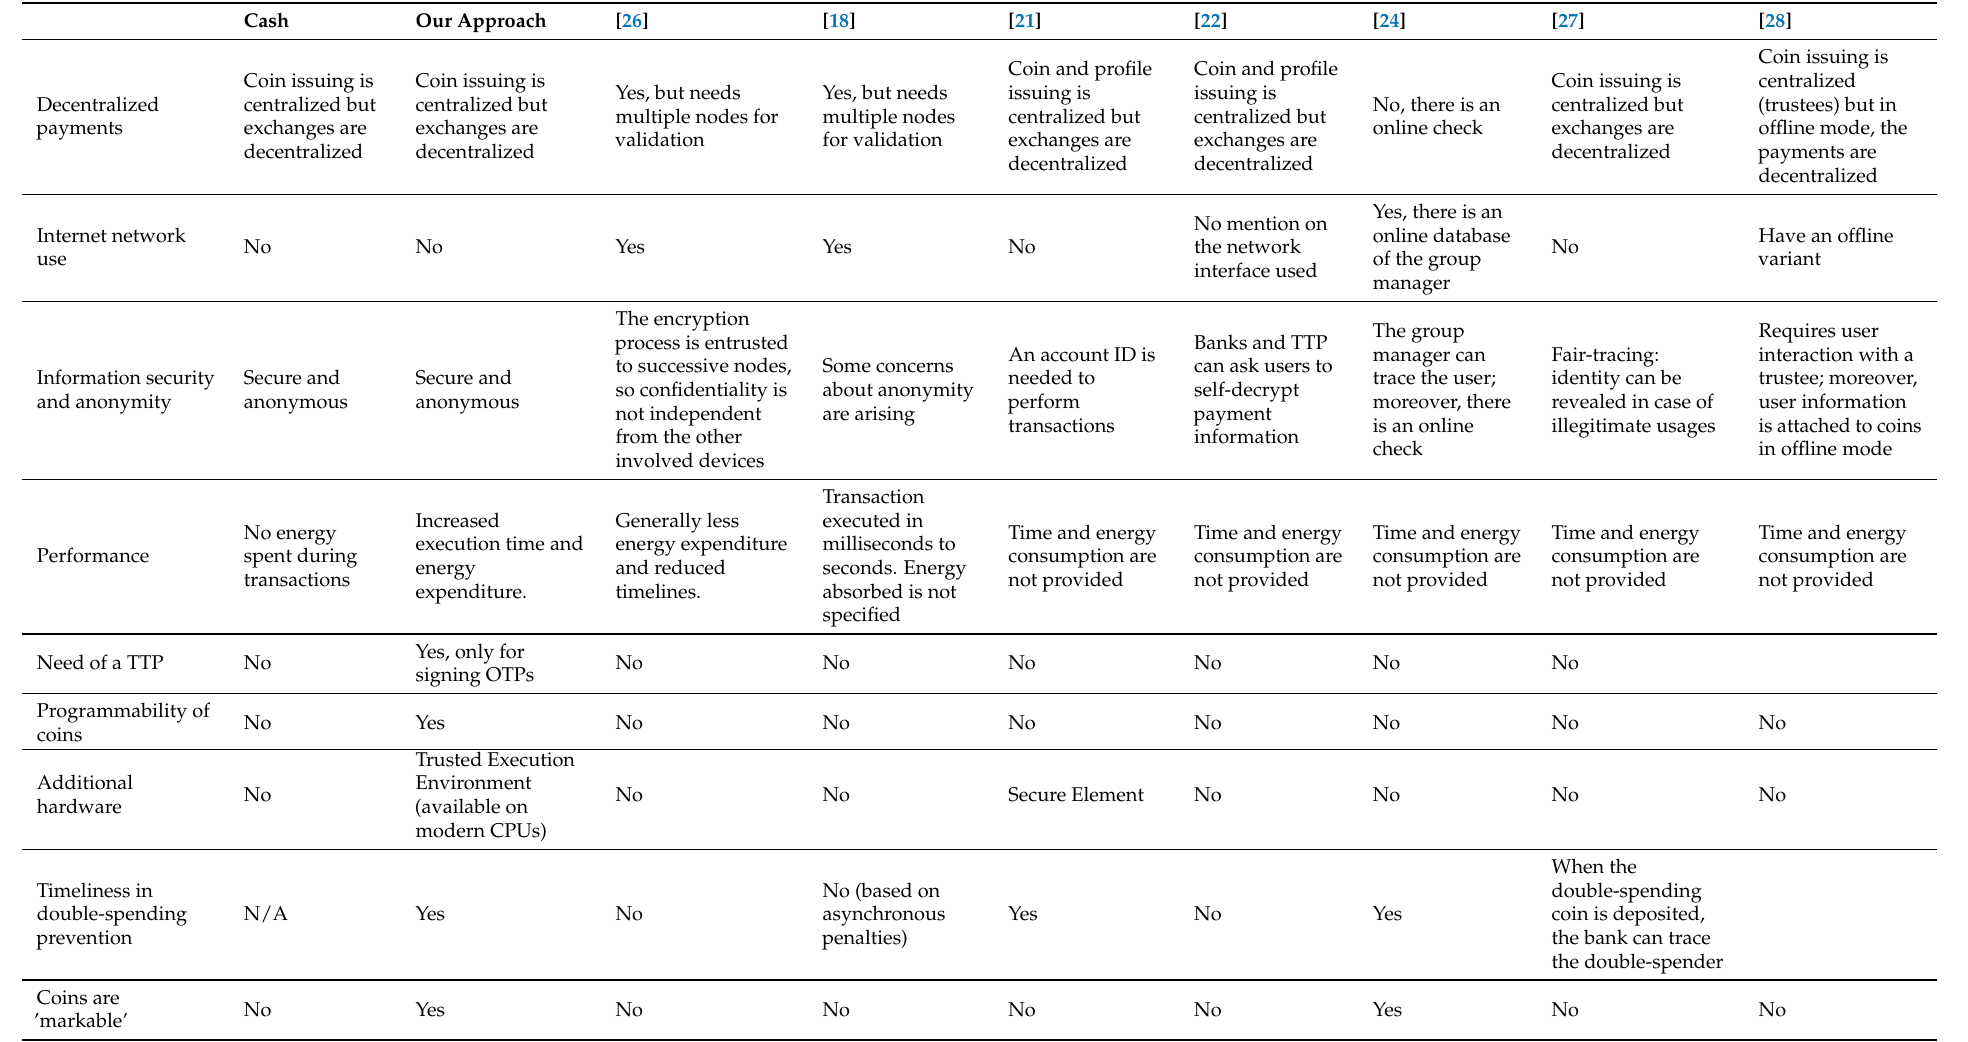
Table 3. Comparison